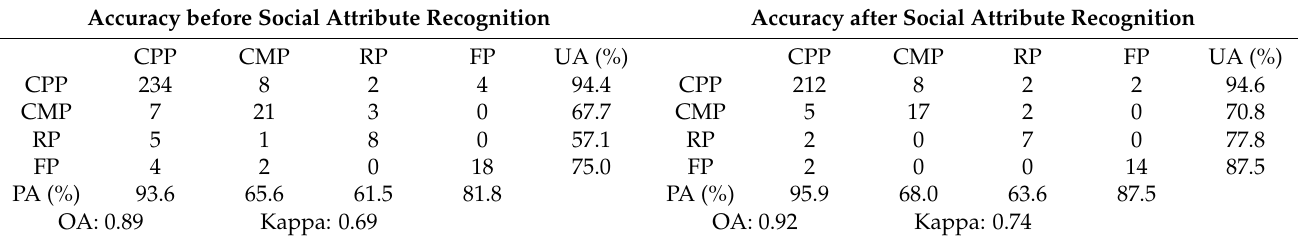
Table 8. Comparison of the effects of social attribute